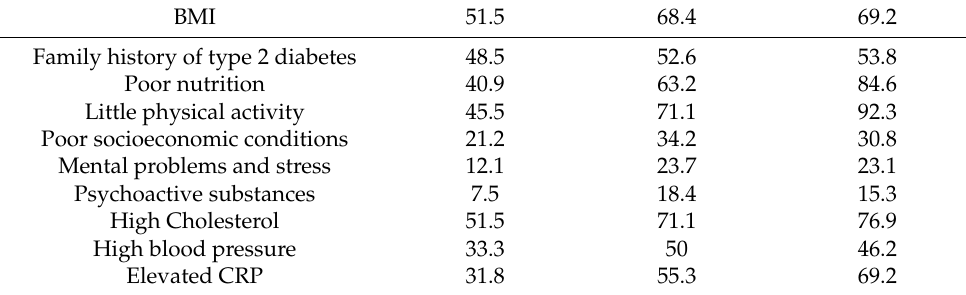
Table 4. Influence risk factors.